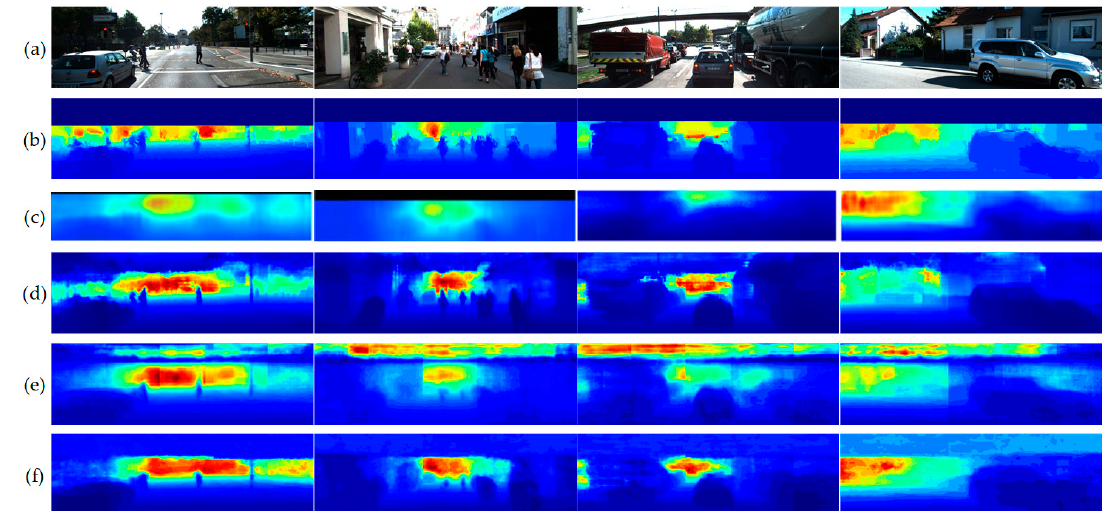
Figure 6. Qualitative comparison of estimated depth-maps on KITTI. ( a ) Input images, ( b ) ground truth, ( c ) multi-scale convolutional architecture [11], ( d ) deep ordinal regression network [14], ( e ) with regression of [11], and ( f ) proposed lightweight efficient neural network.